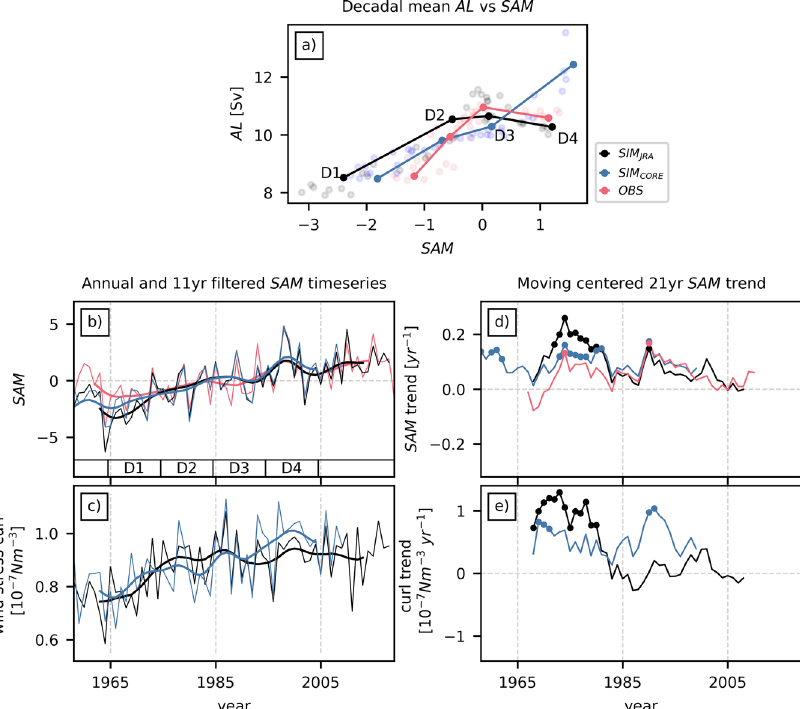
Fig. 4 Decadal trends in Agulhas leakage (AL) since 1958 can only partially be related to changes in the annual Southern Annular Mode (SAM) index. Between the mid-1960s and mid-1980s the increase in AL fi ts to an overall increase in SAM, afterwards AL evolves disproportionally to SAM. a Decadal mean AL vs SAM as simulated in SIM JRA (blue) and SIM CORE (black) (AL LA from Fig. 2a and SAM from panel b of this fi gure), and as inferred from observations (red) (AL SST estimate based on HadISST and SAM from panel b of this fi gure); decadal means for all possible averaging period are displayed by semi-transparent dots, decadal means for subsequent periods D1 (1965 – 1984) to D4 (1995 – 2004) are marked by solid connected dots. Annual (thin lines) and sub-decadally fi ltered (thick lines, 11 yr Hamming window) ( b ) SAM index calculated following Marshall (2003) as the difference (40°S – 65°S) in normalized zonal-mean sea level pressure from station data (OBS) and the JRA55-do (SIM JRA ) and CORE (SIM CORE ) atmospheric forcing data sets; and ( c ) values that are signi fi cant according to student ’ s t -test and 95% con fi dence